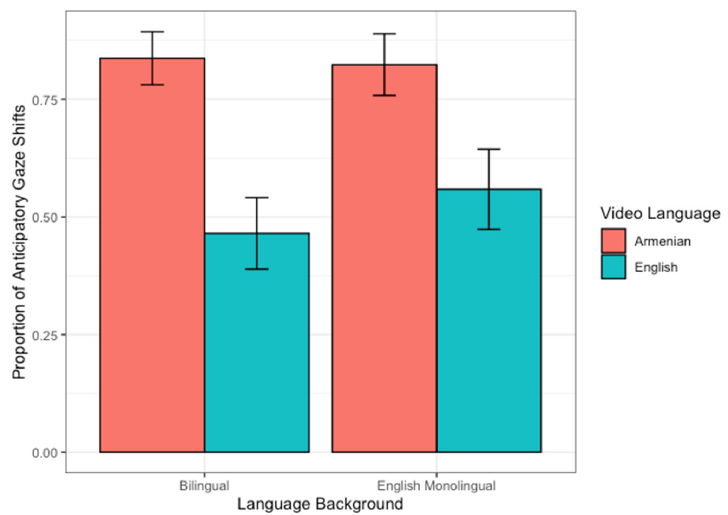
Figure 2. The proportion of anticipatory gaze shifts made by bilingual versus monolingual infants when viewing videos in which speakers spoke in an unfamiliar (Armenian) versus familiar (English) language. Error bars represent 95% confidence intervals.